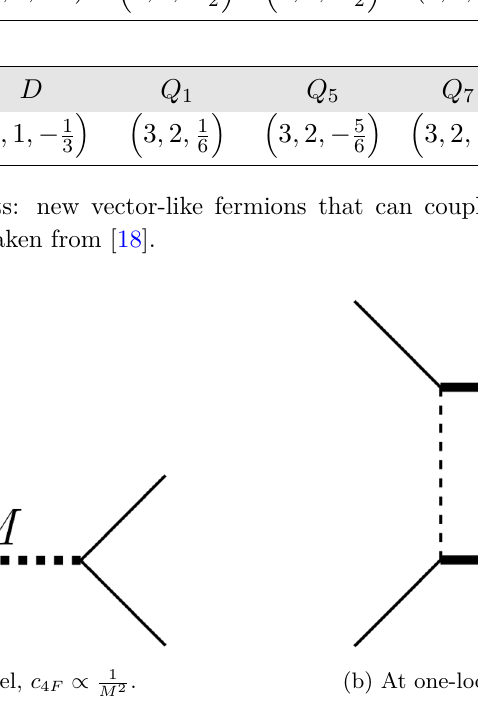
Figure 4. Sample diagrams at tree-level and one-loop level. The one-loop contribution to the Wilson coefficient is suppressed by a factor of 16 π 2 with respect to the tree-level